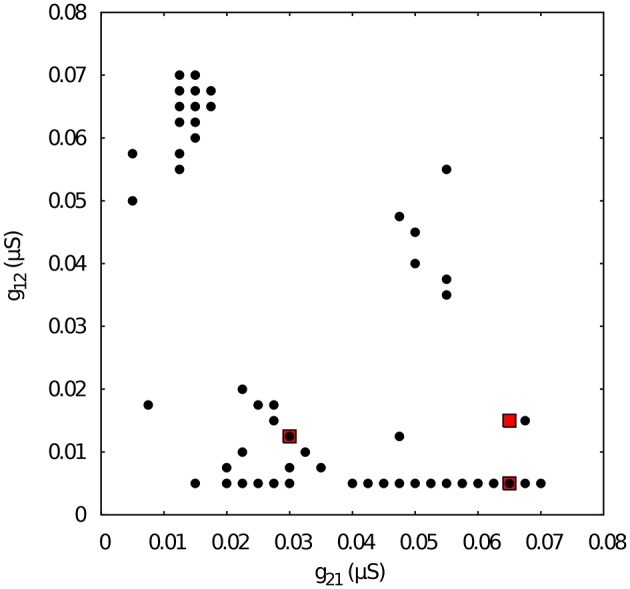
Map of conductances g12 and g21 of the temporal asymmetric mutually inhibitory circuit that lead to regularization of the spiking-bursting activity. The incremental step for both g12 and g21 is 0.0025 μS. Black circles represent values that lead to regular activity (Cv < 5%). The map shows a reduced number of configurations of parameters that leads to regular activity as a consequence of the temporal asymmetry in the connection between the neurons. Parameters: k1 = 0.6 ms−1, k2 = 0.27 ms−1. Red squares correspond to specific values of g12 and g21 that will be used for subsequent analysis of k1 vs k2 maps.